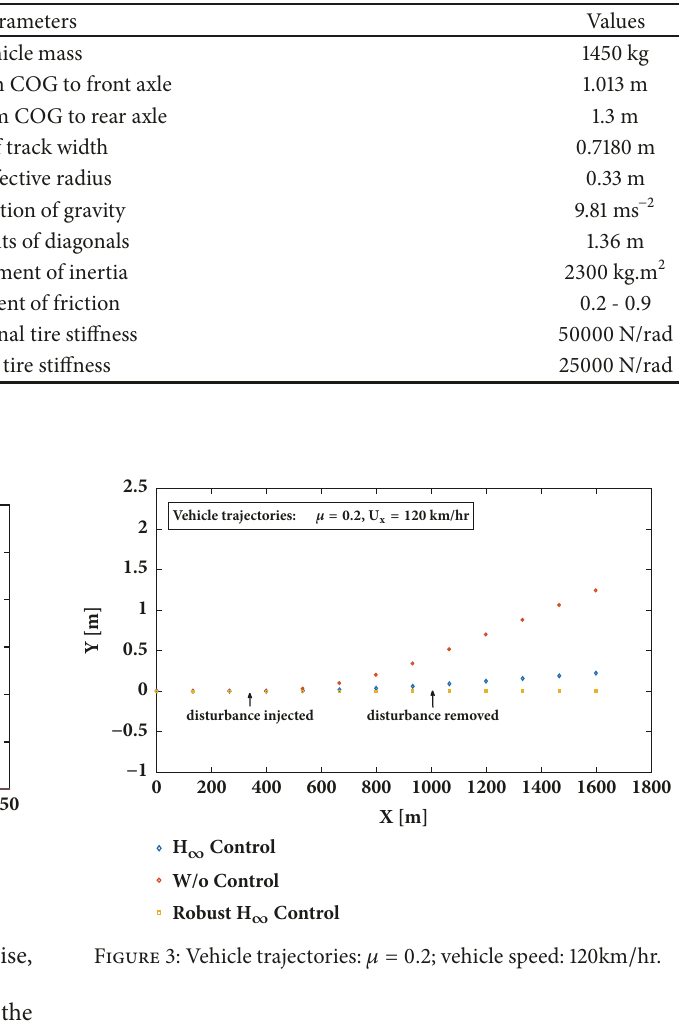
Table 1: Vehicle parameters.